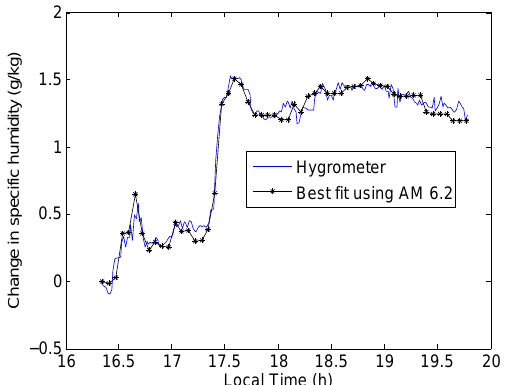
Fig. 7. Change in specific humidity relative to first observation. The black asterisks represent the best fit changes in specific humidity along the signal path to the ATOMMS amplitude ratio spectra each time an ATOMMS amplitude spectra was measured. The blue curve shows the changes in specific humidity as measured by the nearby hygrometer on the PAS